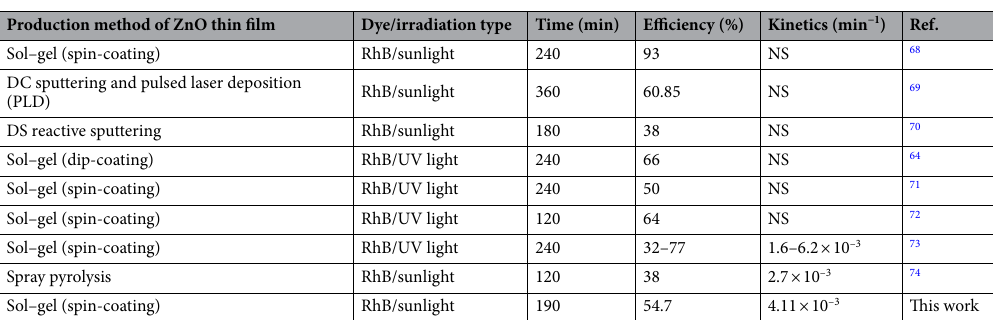
Table 3. Comparison between different ZnO thin films efficiencies in other works. NS not studied.